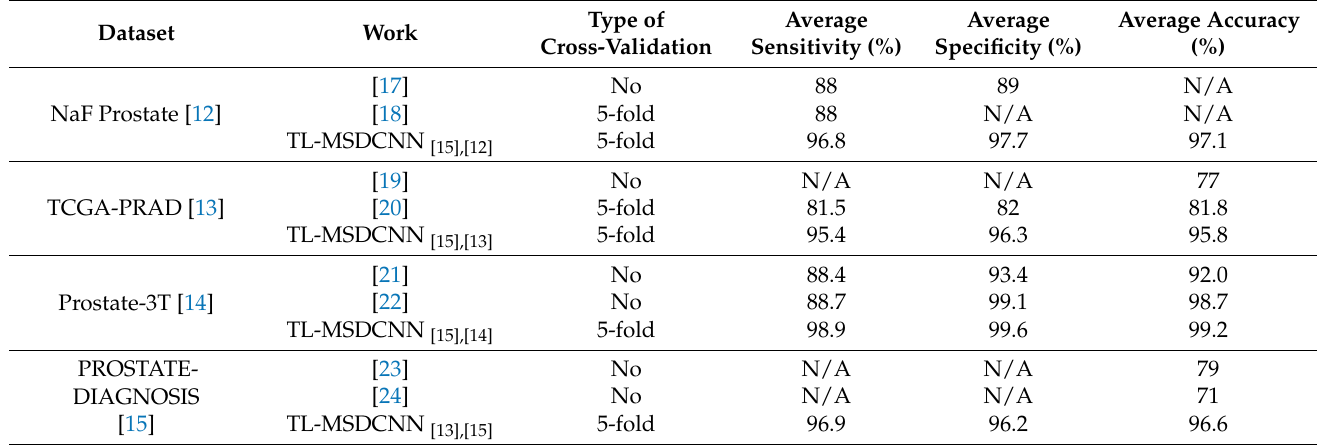
Table 4. Performance comparison between TL-MSDCNN and existing works.